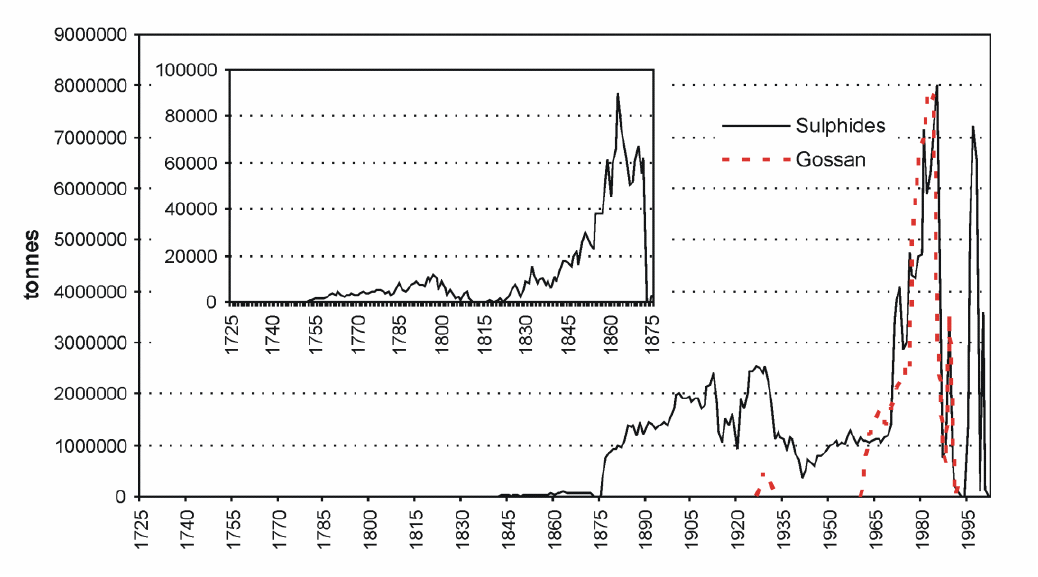
Figure 4. Evolution of sulphide and gossan production (run-of-mine ore) in the Río Tinto mine from the eighteenth century to the